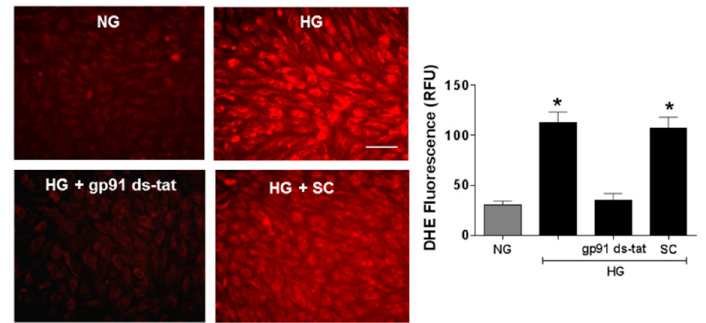
Figure 5. NOX2 blockade prevents high glucose-induced increases in oxidative stress. Representative images and statistical analysis of dihydroethidium (DHE) imaging showing effects of high glucose on reactive oxygen species (ROS) formation in endothelial cells. Treatment with high glucose (HG) markedly increased the DHE fluorescence as compared with the normal glucose controls (NG). Treatment with the NOX2-blocking peptide gp91ds-tat but not the scrambled control (SC) peptide blocked the HG-induced increase in ROS. * p < 0.05, n = 10. Scale bar = 20 µ m.